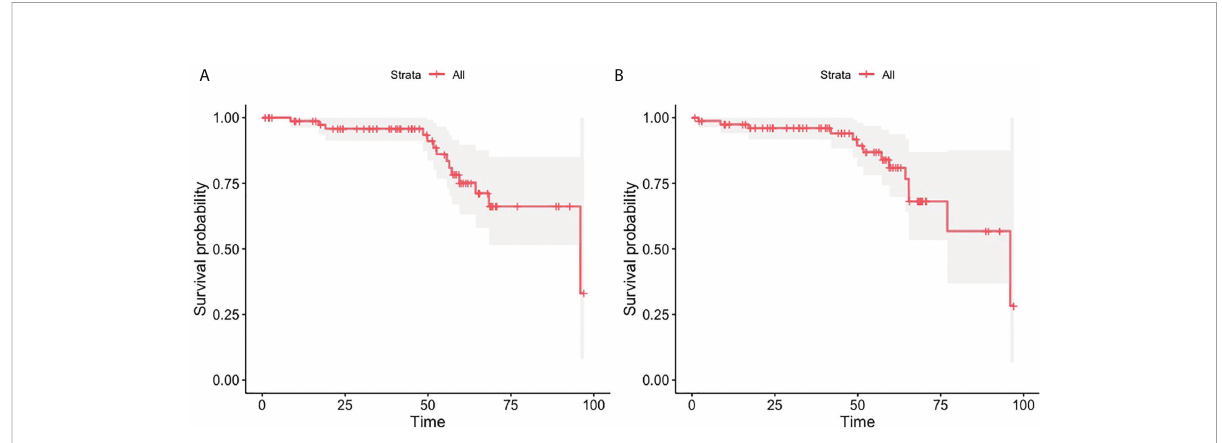
FIGURE 1 The Kaplan-Meier plots showing overall survival (A) and progression- free survival (B) in the whole cohort of 86 CML patients treated with